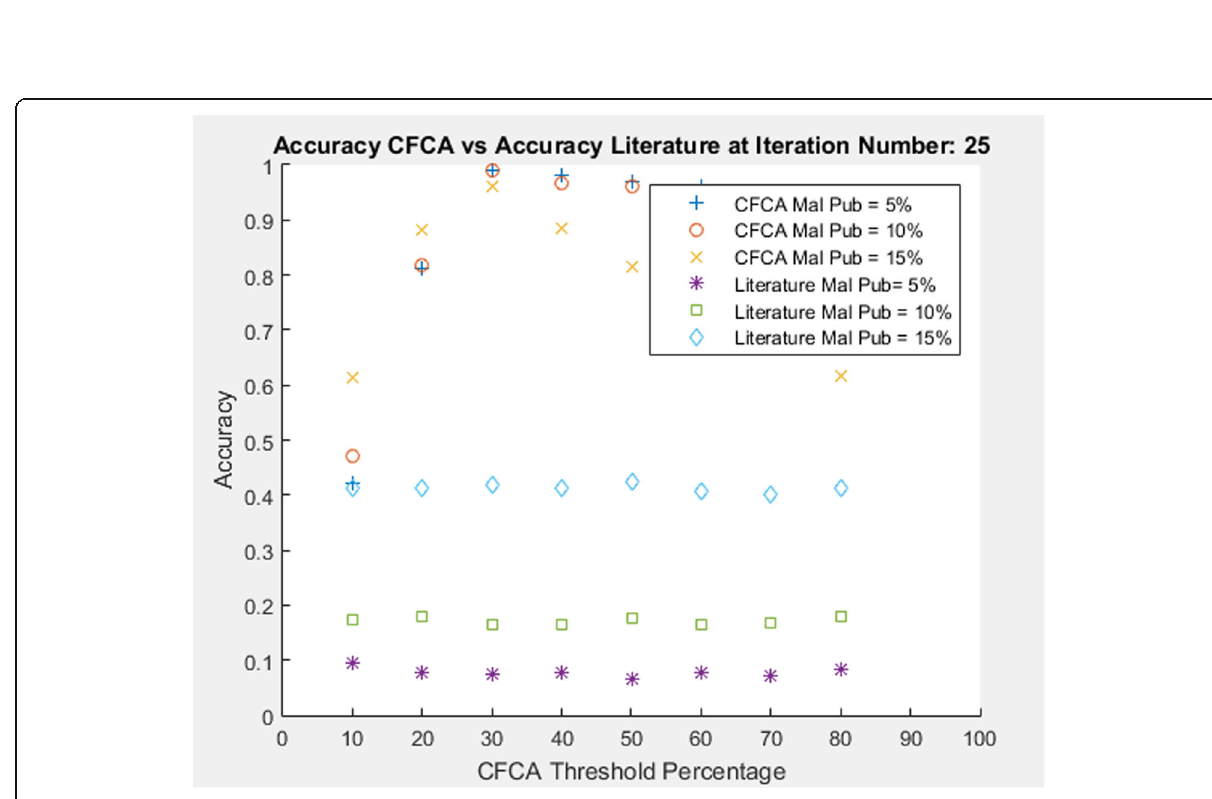
Fig. 7 Accuracy CFCA vs accuracy literature at iteration I =